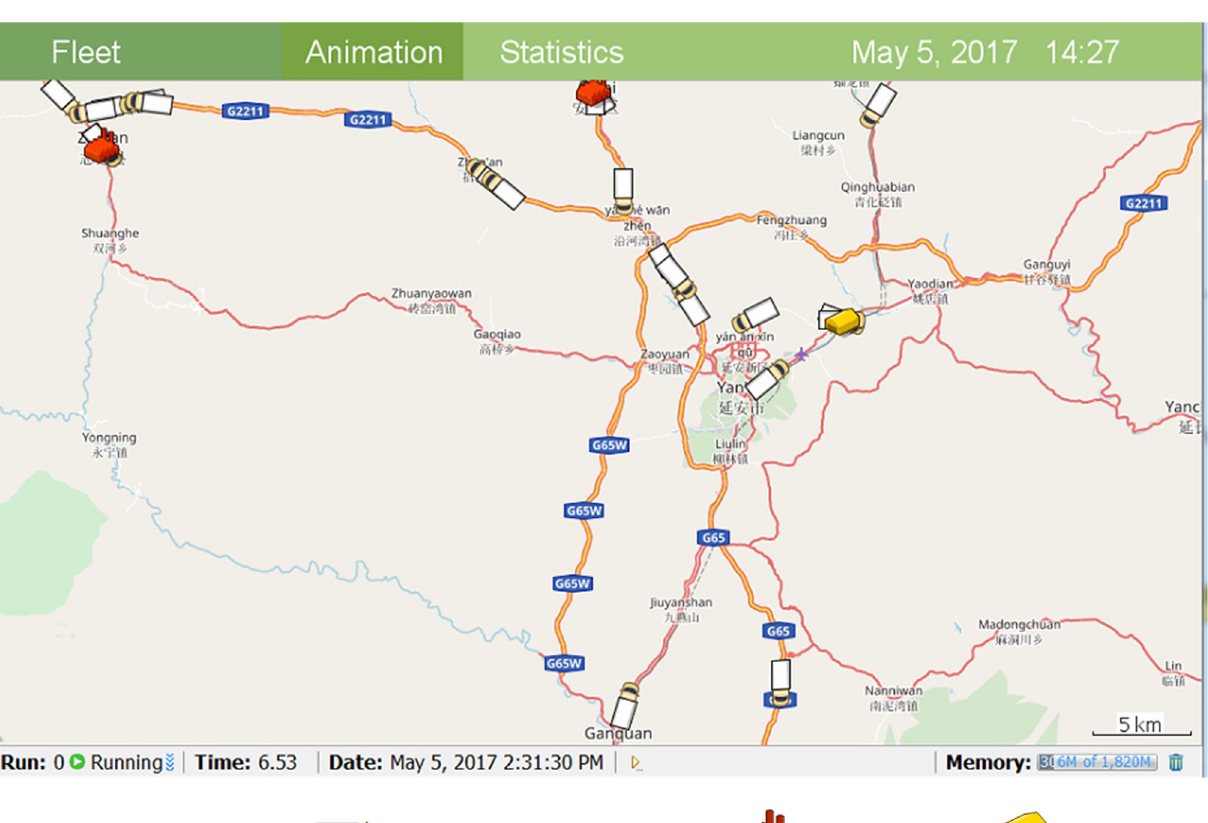
Fig. 4 Verification of the simulation ( : tractor with physical internet container; : manufacturing site; : freight